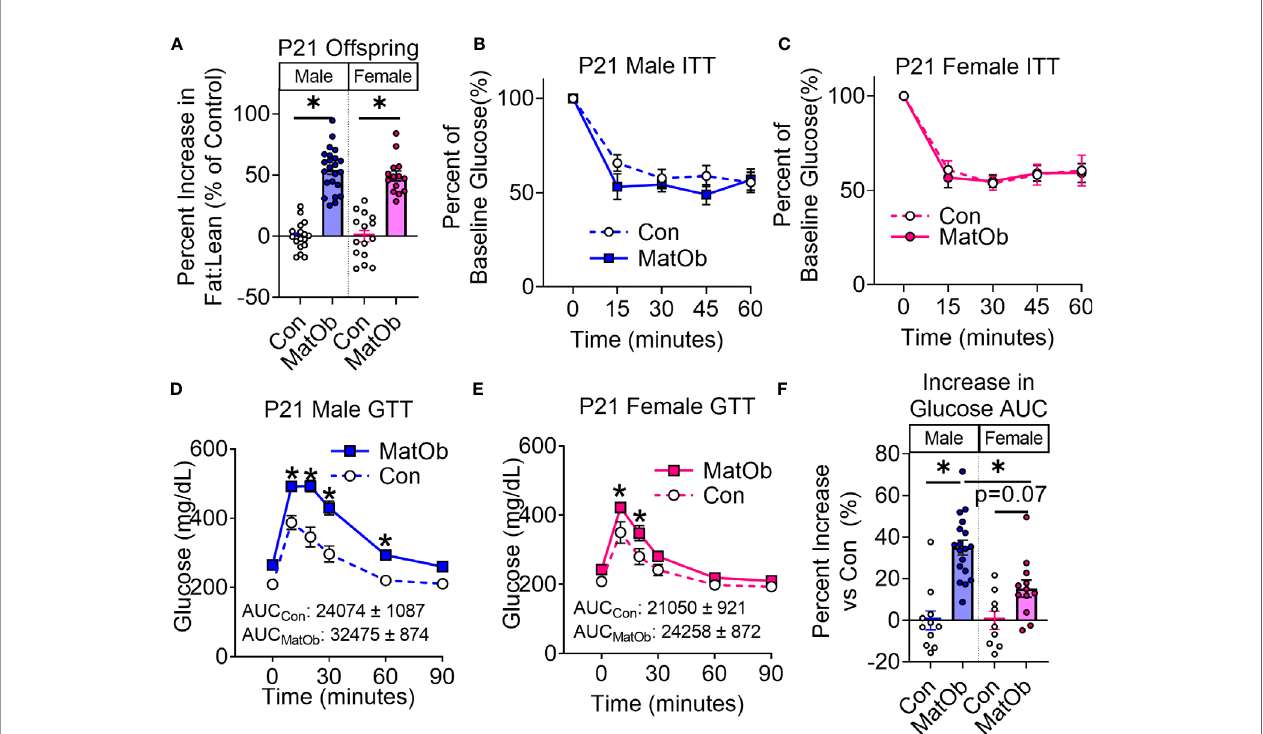
FIGURE 2 | P21 Offspring of obese dams (MatOB) had similar extent of increase body adiposity and unchanged ITT, but exhibited sex-differences in glucose intolerance. (A) Percentage changes of fat:lean ratio (normalized to same-sex controls) showing increased total body adiposity in both male and female MatOB offspring (n=15-23/group). Insulin tolerance was unchanged in P21 (B) male (n=8-10/group) and (C) female offspring (n=9-10/group). (D) P21 male MatOb offspring have signi fi cantly increase in glucose excursion curve during glucose tolerance testing (n=11-18/group), while (E) P21 female MatOb offspring had lesser extent of glucose intolerance (n=9-12/group). (F) Percent increase in GTT glucose AUC showing male MatOb offspring have signi fi cantly decreased glucose tolerance. Experimental animals originated from at least 5 litters. *p <